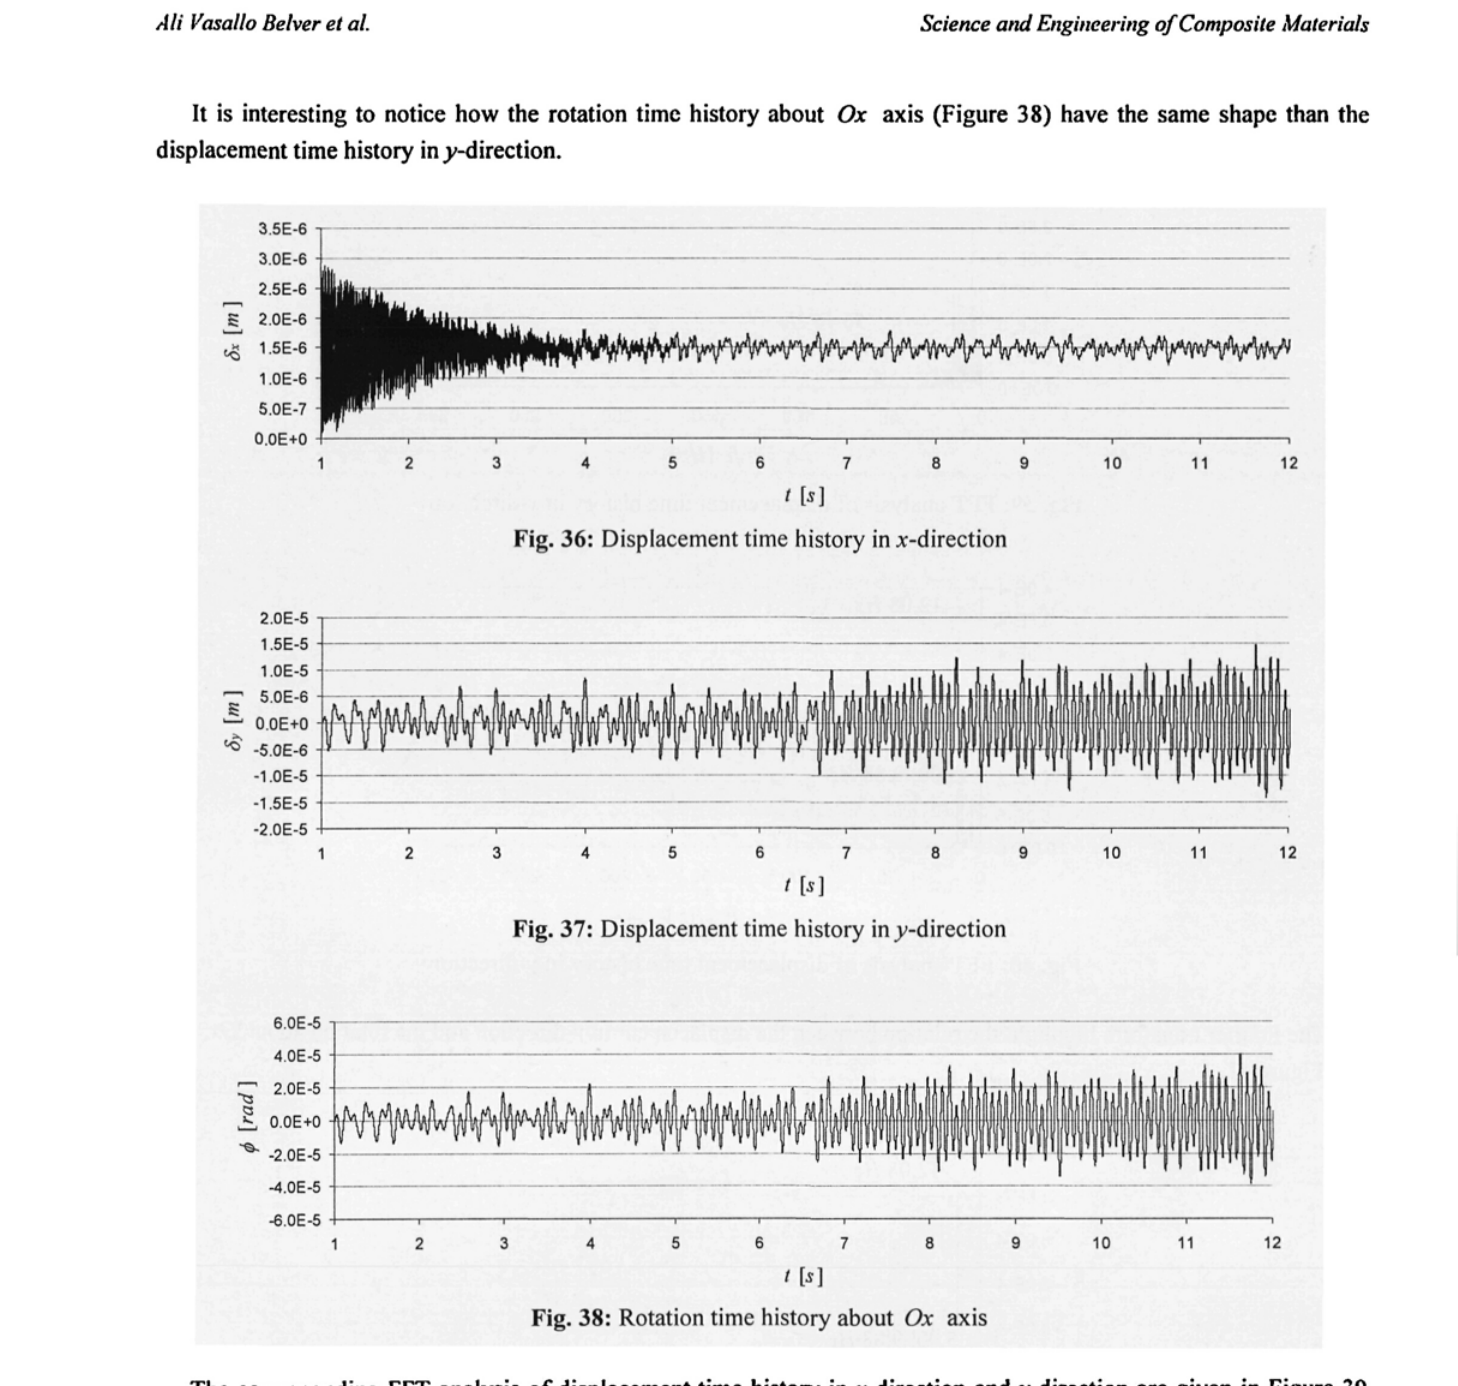
Fig. 38: Rotation time history about Ox